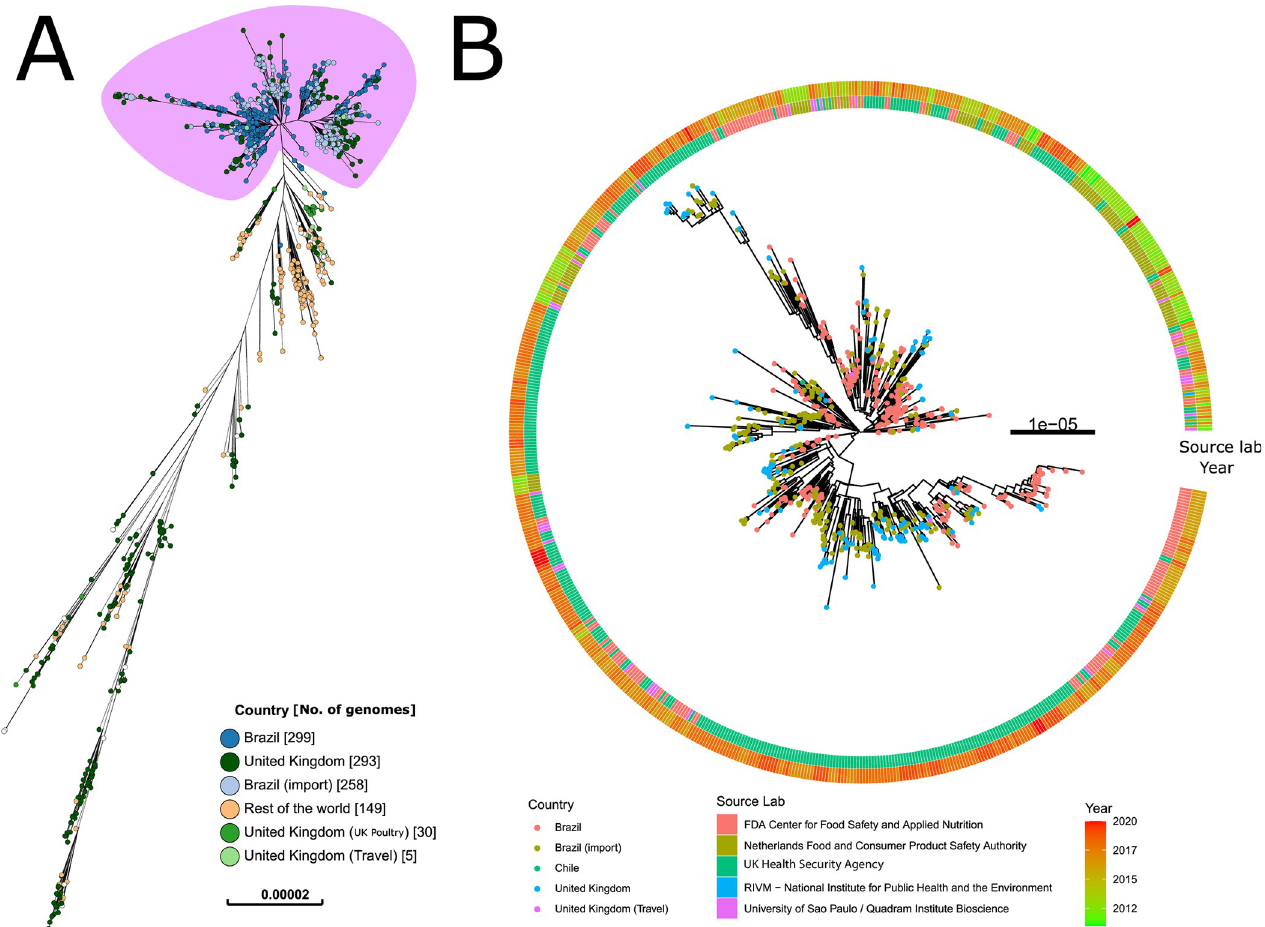
Fig 2. Phylogeny of global Salmonella Heidelberg including Brazil and UK (domestic/imported food/travel) isolates. (A) Maximum likelihood phylogenetic tree of Salmonella Heidelberg genomes, including isolates from Brazil, imported chicken meat from Brazil, domestic UK poultry, and representatives from the rest of the world. Nodes are coloured by country of origin as indicated in the key. An interactive version of this figure with supporting metadata is available at https://microreact.org/project/brch-fig2a (B) Maximum likelihood phylogenetic tree of genomes highlighted in lilac in part A. Tips were colour coded according to sample origin. Inner ring indicates the source lab. Outer ring indicates the collection year. An interactive version of this figure with supporting metadata is available at https://microreact.org/project/brch-fig2b.